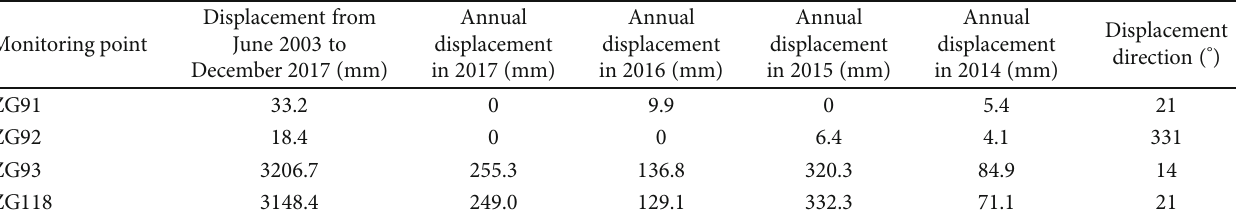
Figure 2: (a) Road damage at the western boundary of the warning zone. (b) Local slumps in the warning zone. Table 1: Deformation characteristics including total displacement, annual displacement, and displacement direction for monitoring points inside and outside the warning